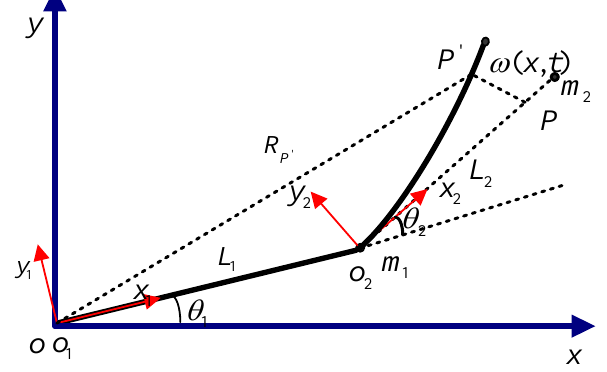
Figure 1. Structure diagram of the rigid-flexible manipulators. In Figure 1, o - xy represents the inertial coordinate frame, and o 1 - x 1 y 1 and o 2 - x 2 y 2 are the moving coordinate frames with origin at the hubs of links 1 and 2, respectively. In addition, m 1 is the mass of the second hubs, m 2 is the mass of the tip load, θ 1 and θ 2 are respectively the revolving angles of the two links with respect to their frames, L 1 and L 2 are respectively the length of the two links, ω ( x , t ) is the transverse elastic